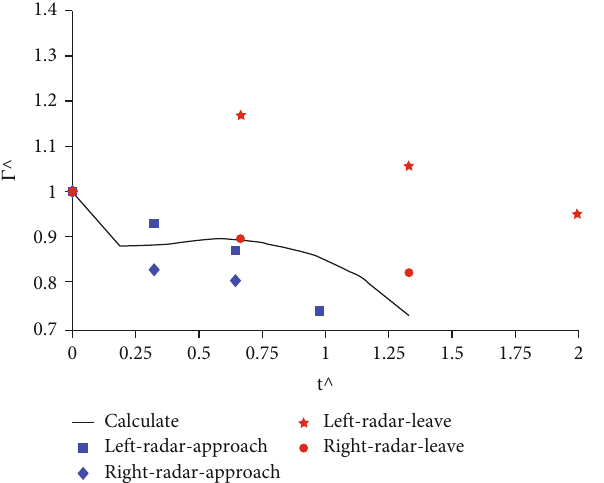
Figure 11: Comparison of wake vortex height variation between radar detection and numerical simulation